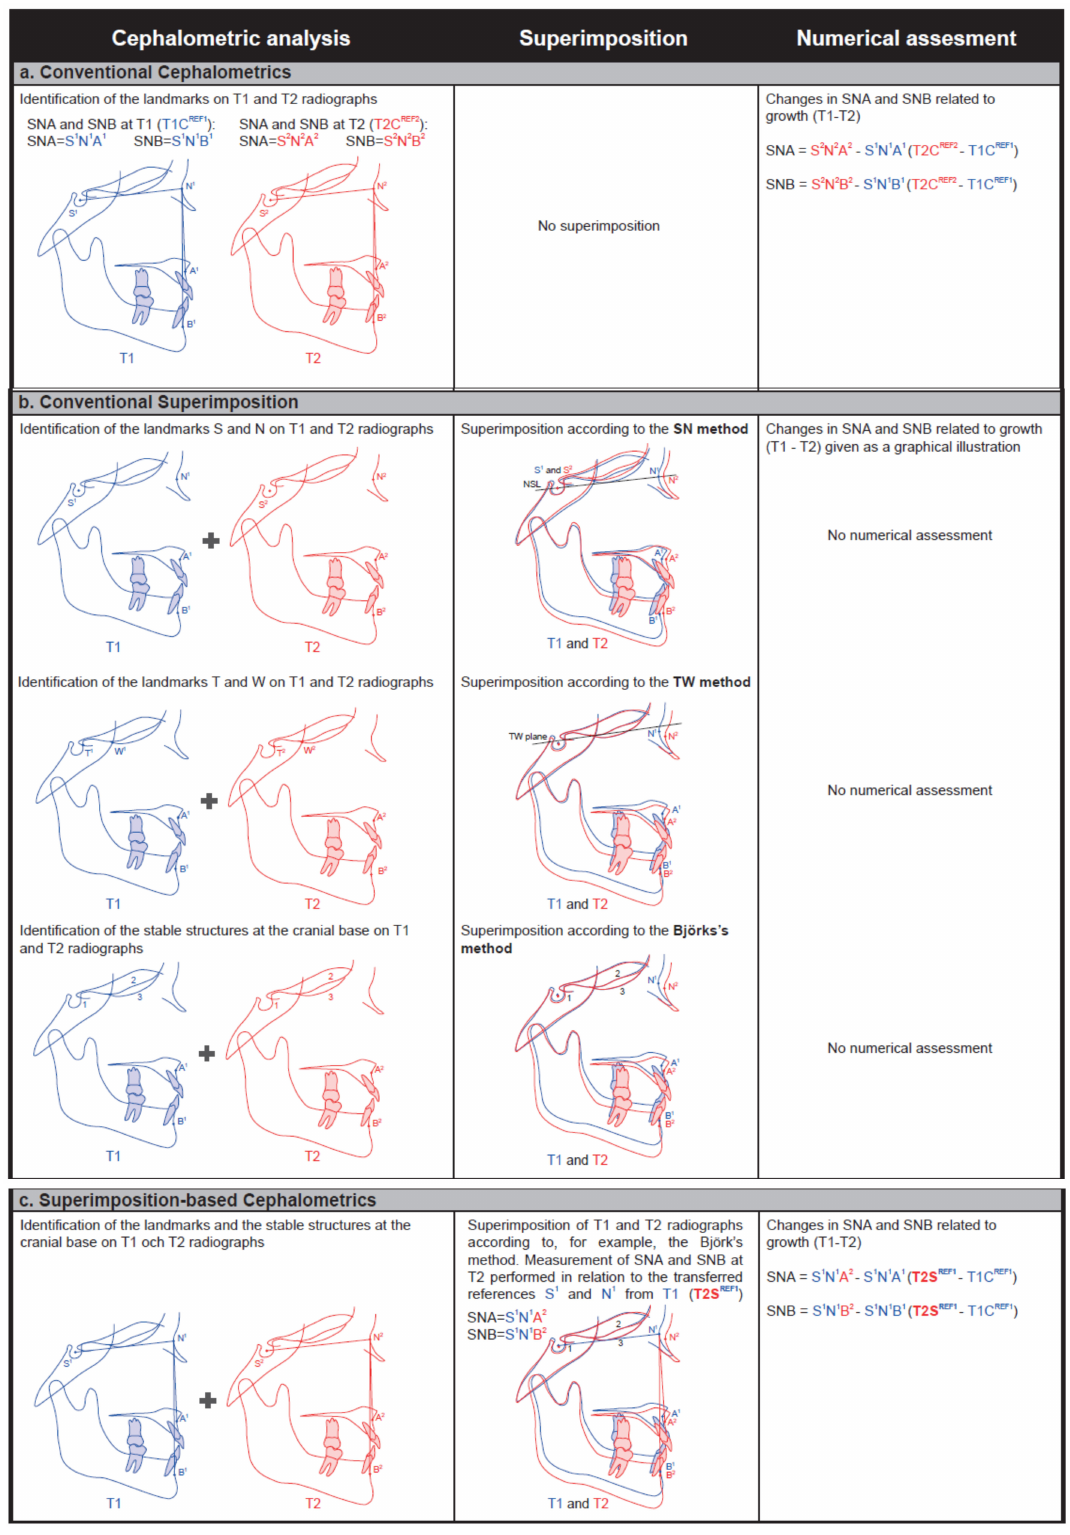
Figure 2. Evaluations of craniofacial changes related to growth and treatment (e.g., SNA and SNB) are performed using three methods: ( a ), conventional cephalometrics; ( b ), conventional superimposition; and ( c ), superimposition-based